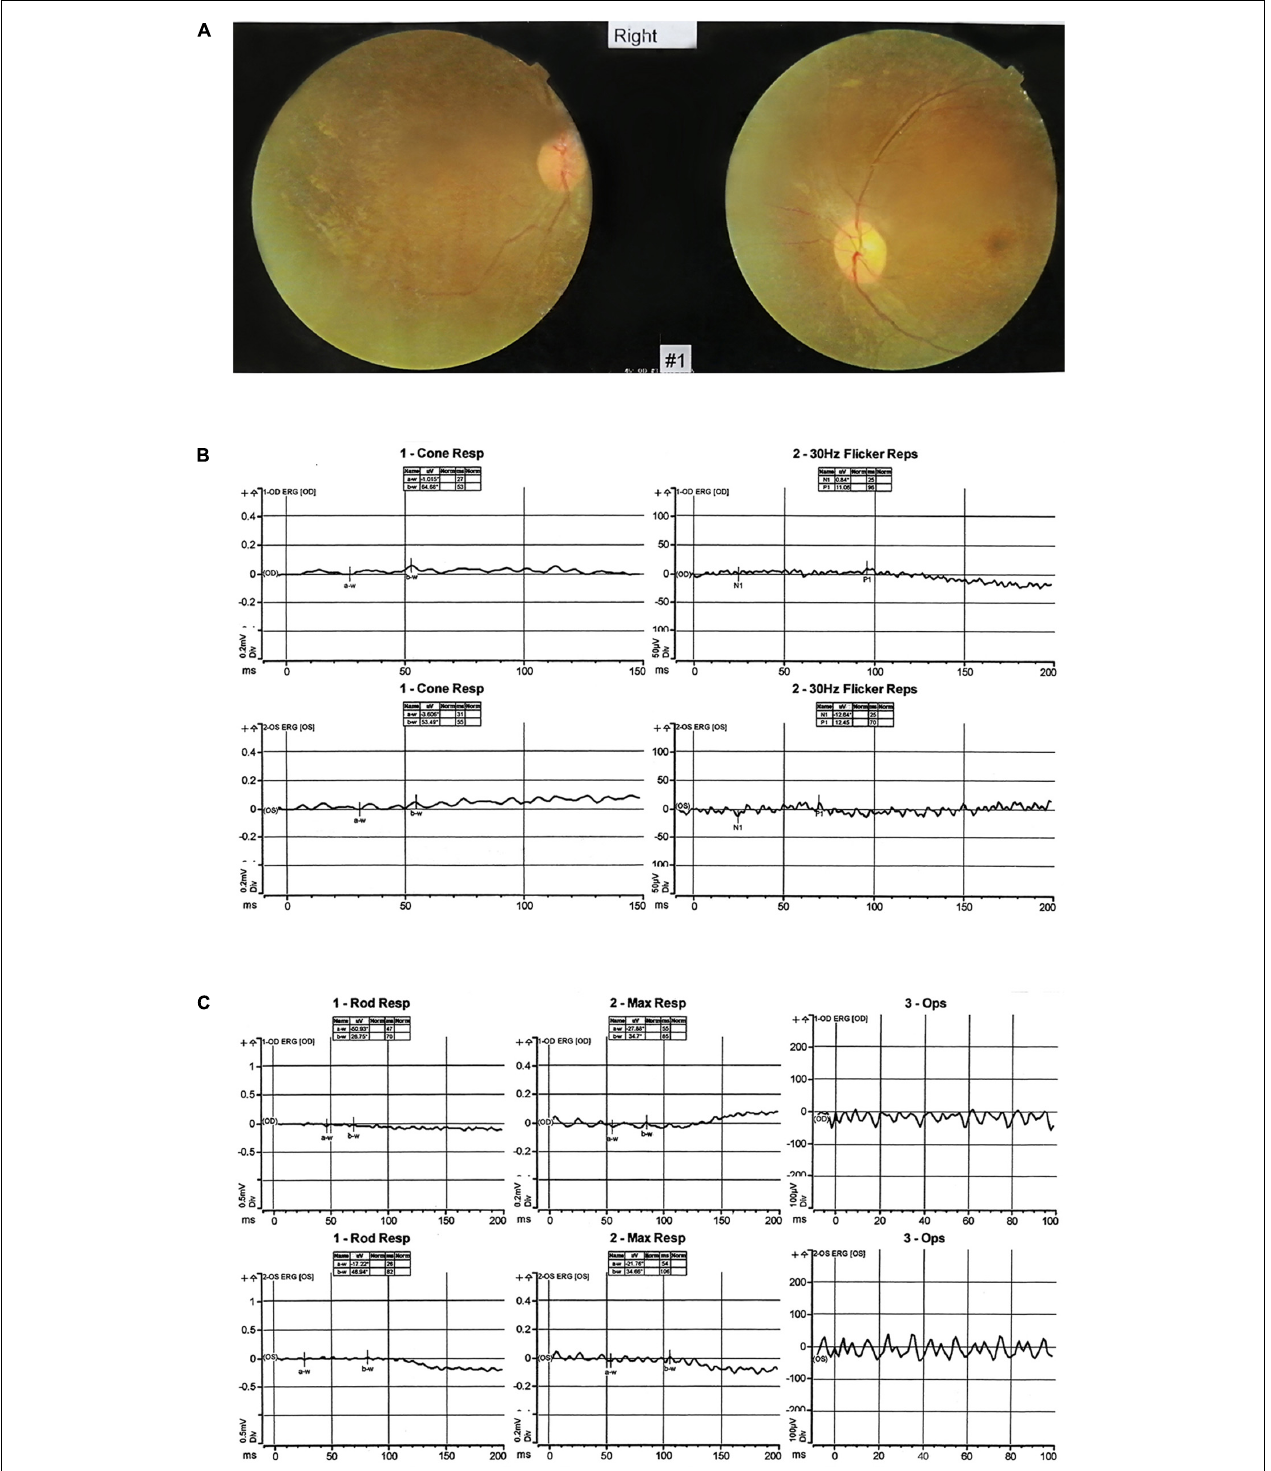
FIGURE 2 | Clinical features. (A) The fundus imaging result of the proband (III:1). The fundus imaging shows that the eye position is not correct, the retinal artery is thinned, and the blood vessel is accompanied by a white sheath. (B,C) The electroretinography result of the proband (III:1). After dark adaptation for 20 min, the rod cell response b-w wave basically disappeared, the maximum mixed response a-w wave basically disappeared, and the peak amplitude of oscillatory potentials decreased. After light adaptation for 10 min, the peak amplitude of the cone response b-w wave decreased significantly, and the 30-Hz scintillation light response amplitude decreased. It reflects that the inner and outer layers of the retina are damaged, and the retina is in an ischemic state.